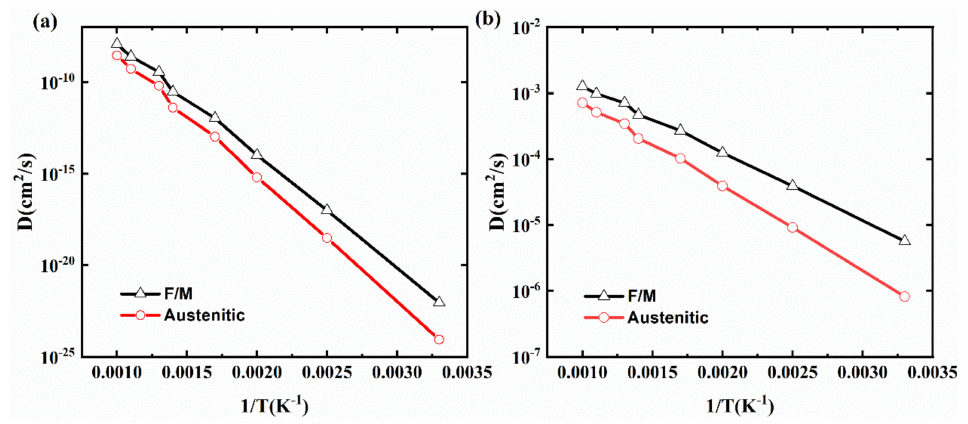
Figure 7. ( a ) The diffusion coefficients of vacancy, ( b ) the diffusion coefficients of SIA in F/M steels and austenitic steels under different temperatures.